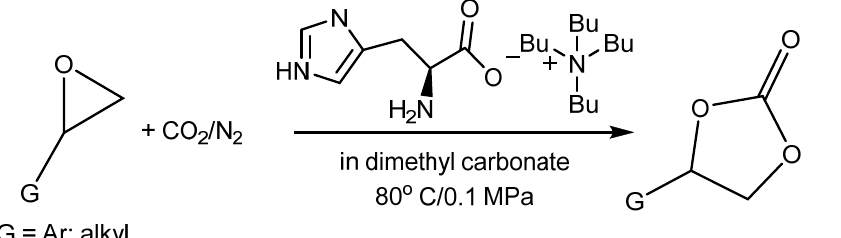
Scheme 13. Carbonation of terminal epoxides using model flue gas (5–15% CO 2 in nitrogen) [103].